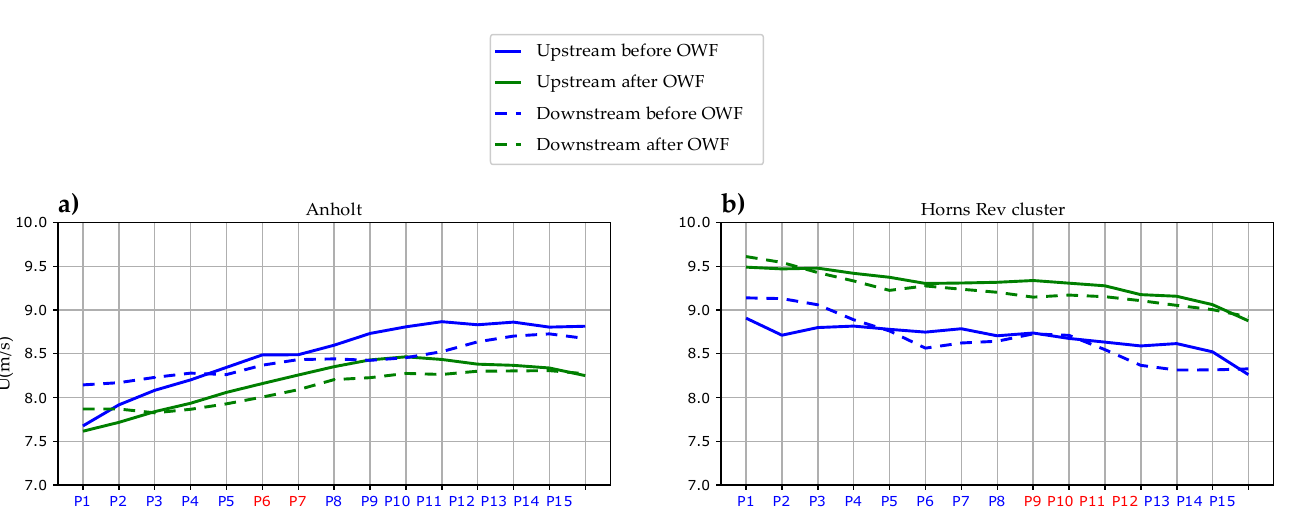
Figure 7. Velocity deficit ( ∆ U ) for easterly winds over the OWFs and clusters. See Figure 5 for the definitions of lines. ( a ) Anholt; ( b ) Horns Rev cluster; ( c ) Butendiek; ( d ) Nordsee cluster; ( e ) East Anglia One; ( f ) Global Tech cluster; ( g ) Greater Gabbard & Galloper; ( h ) Hornsea Project One. 3.3. Mean Wind Speed and Velocity Deficit: Southerly Winds When winds are coming from southerly directions, all the eight sites are exposed to winds from the land but the fetch is variable. The blue curves in Figure 8 indicate that the HCWSGs before sites’ commissioning dates are always smaller than 0.5 m/s, whereas larger gradients are found for the westerly and easterly wind sectors for some of the OWFs. Again, we find significant changes in the wind speeds for the periods before and after commissioning, especially at Horns Rev, Butendiek, and Greater Gabbard and Galloper (Figure 8b,c,g). The green curves show that the wind speed is lower after OWF commissioning for all the OWFs except the Horns Rev cluster and Hornsea Project One (Figure 8b,h).